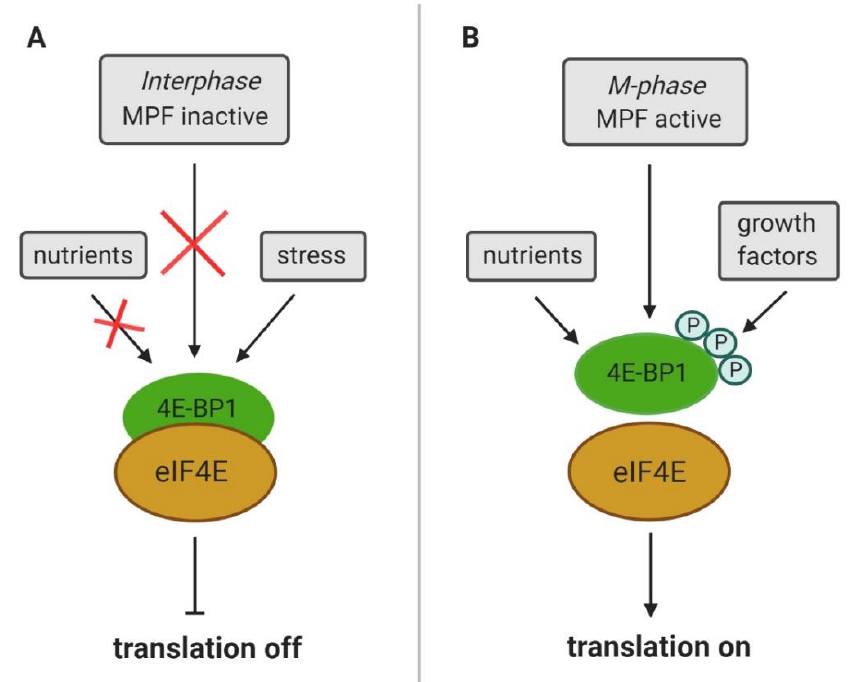
Figure 3. Positive and negative factors affecting eukaryotic translation initiation. ( A ) Inactivity of M phase-promoting factor (MPF) during interphase; lack of nutrients or stress lead to dephosphorylation of eukaryotic translation initiation factor 4E (eIF4E)-binding protein 1 (4E-BP1) which results in formation of translational repressory complex on mRNA. ( B ) Active MPF, availability of nutrients or growth factors lead to hyperphosphorylation of 4E-BP1 resulting in dissociation from eIF4E and promoting formation of 4F complex and translation of specific mRNAs (e.g., mRNAs containing 5′ UTR TOP motive).